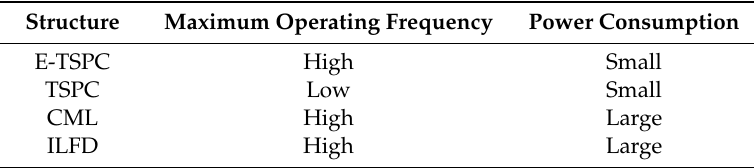
Table 1. Performance of different structures of frequency divider.